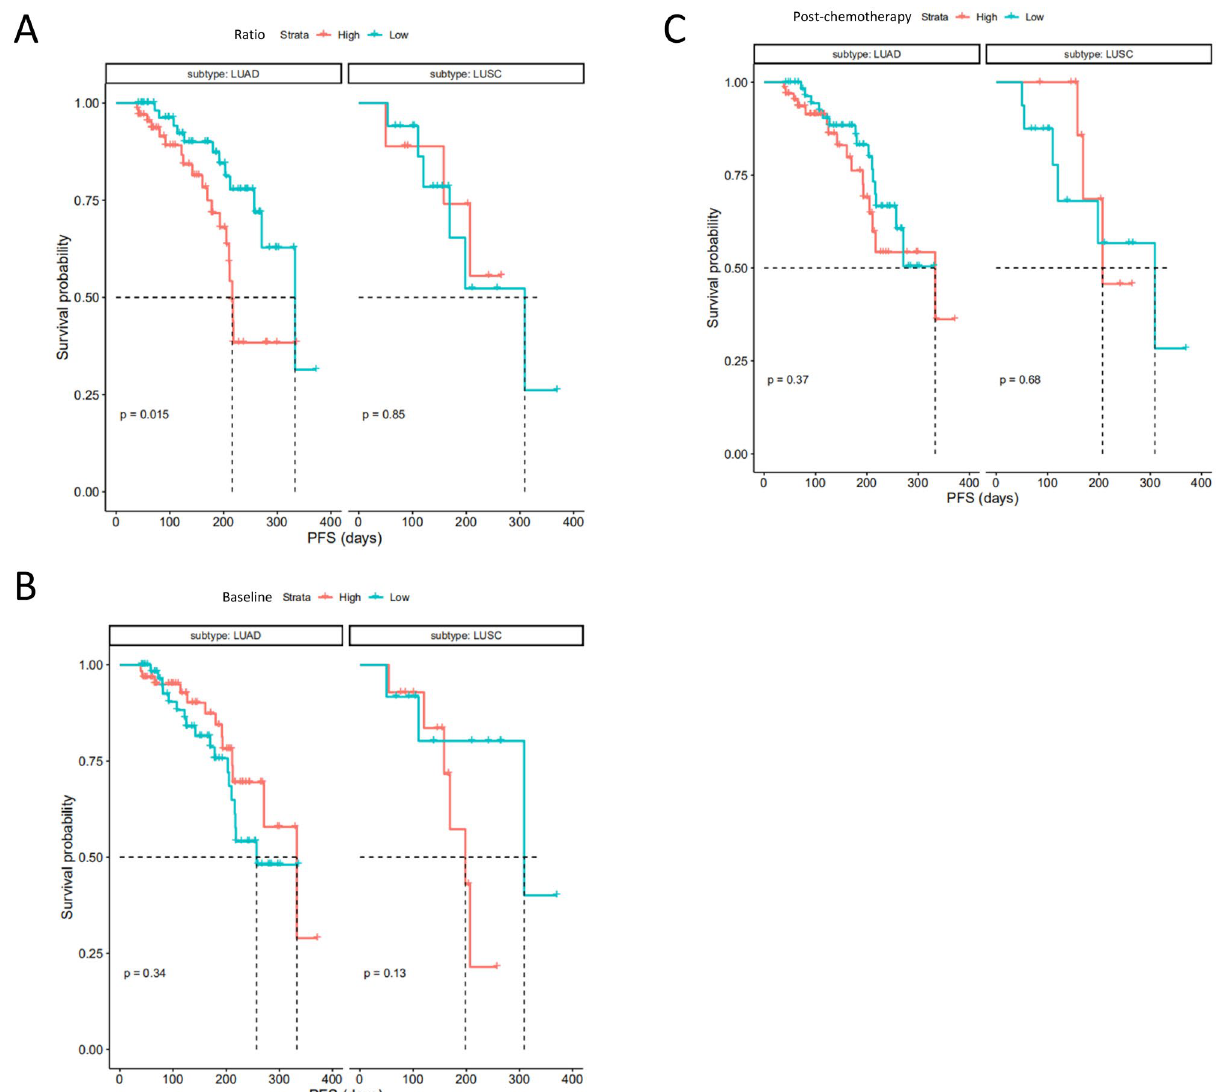
Figure 4. Progression-free survival (PFS)/disease free survival (DFS) analysis by pathological subtype. Stratification analysis of PFS/DFS by pathological subtype (LUAD, N = 128 and LUSC, N = 26) ( A ) high cfDNA Ratio and low cfDNA Ratio groups, ( B ) high cfDNA baseline and low cfDNA baseline groups, ( C ) high post- therapy cfDNA and low post-therapy cfDNA groups (cut-values were set as median value), respectively. PFS/ DFS was assessed according to Response Evaluation Criteria in Solid Tumors, version 1.1 through investigators’ review, and tick marks represent data censored at the last time the patient was known to be alive and without disease